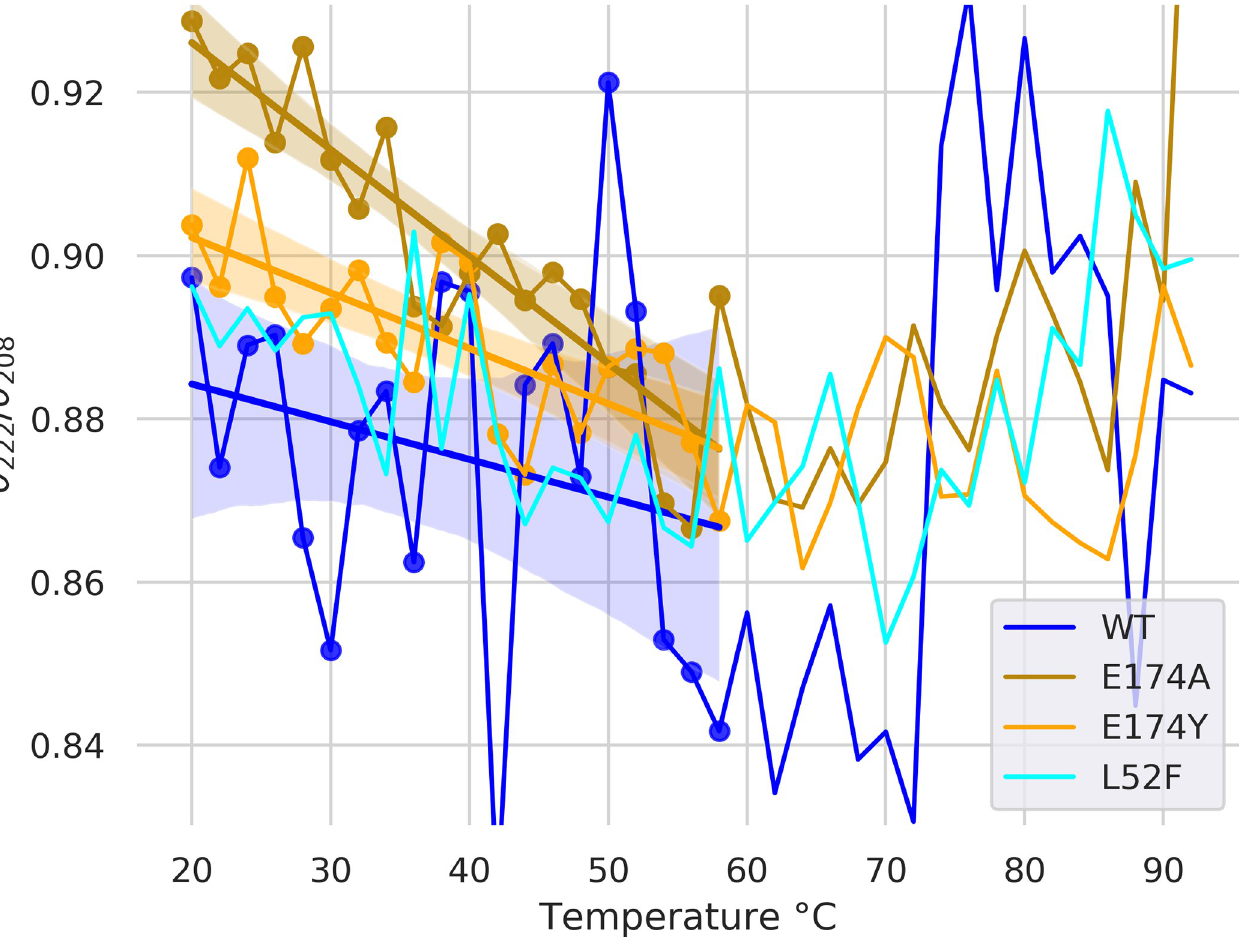
Fig 3. Mutations at position E174 affect θ 222/ θ 208. We plotted θ 222/ θ 208, for temperatures from 20 to 92C. Ratios greater than unity typically indicate coiled-coils. θ 222/ θ 208 did not exceed unity for E174A. θ 222/ θ 208 lower than 0.9 indicates helices in isolation [20], and indeed there is no clear coiled-coiling in experimental hGH structures (see PDB ID 1A22). Differences in ratio (comparing WT to E174A and E174Y) are greater at the lower end of the temperature range, presumably due to greater overall order. Linear regressions are shown for all variants (except for L52F, left out for clarity) over the temperature range of 20 to 58C (in which θ 222/ θ 208 varies linearly). Also shown are 95% confidence intervals for the regressions (generated by the seaborn regplot function, in light shading). E174A has clearly higher θ 222/ θ 208 than E174Y and WT. E174Y has somewhat higher θ 222/ θ 208 than WT. L52F is a control, as it is not in a helix and not near the zinc-binding triad; its θ 222/ θ 208 is indistinguishable from that of WT, and is less than that of E174A. E174A / E174Y increase θ 222/ θ 208 ratio, while L52F has no clear